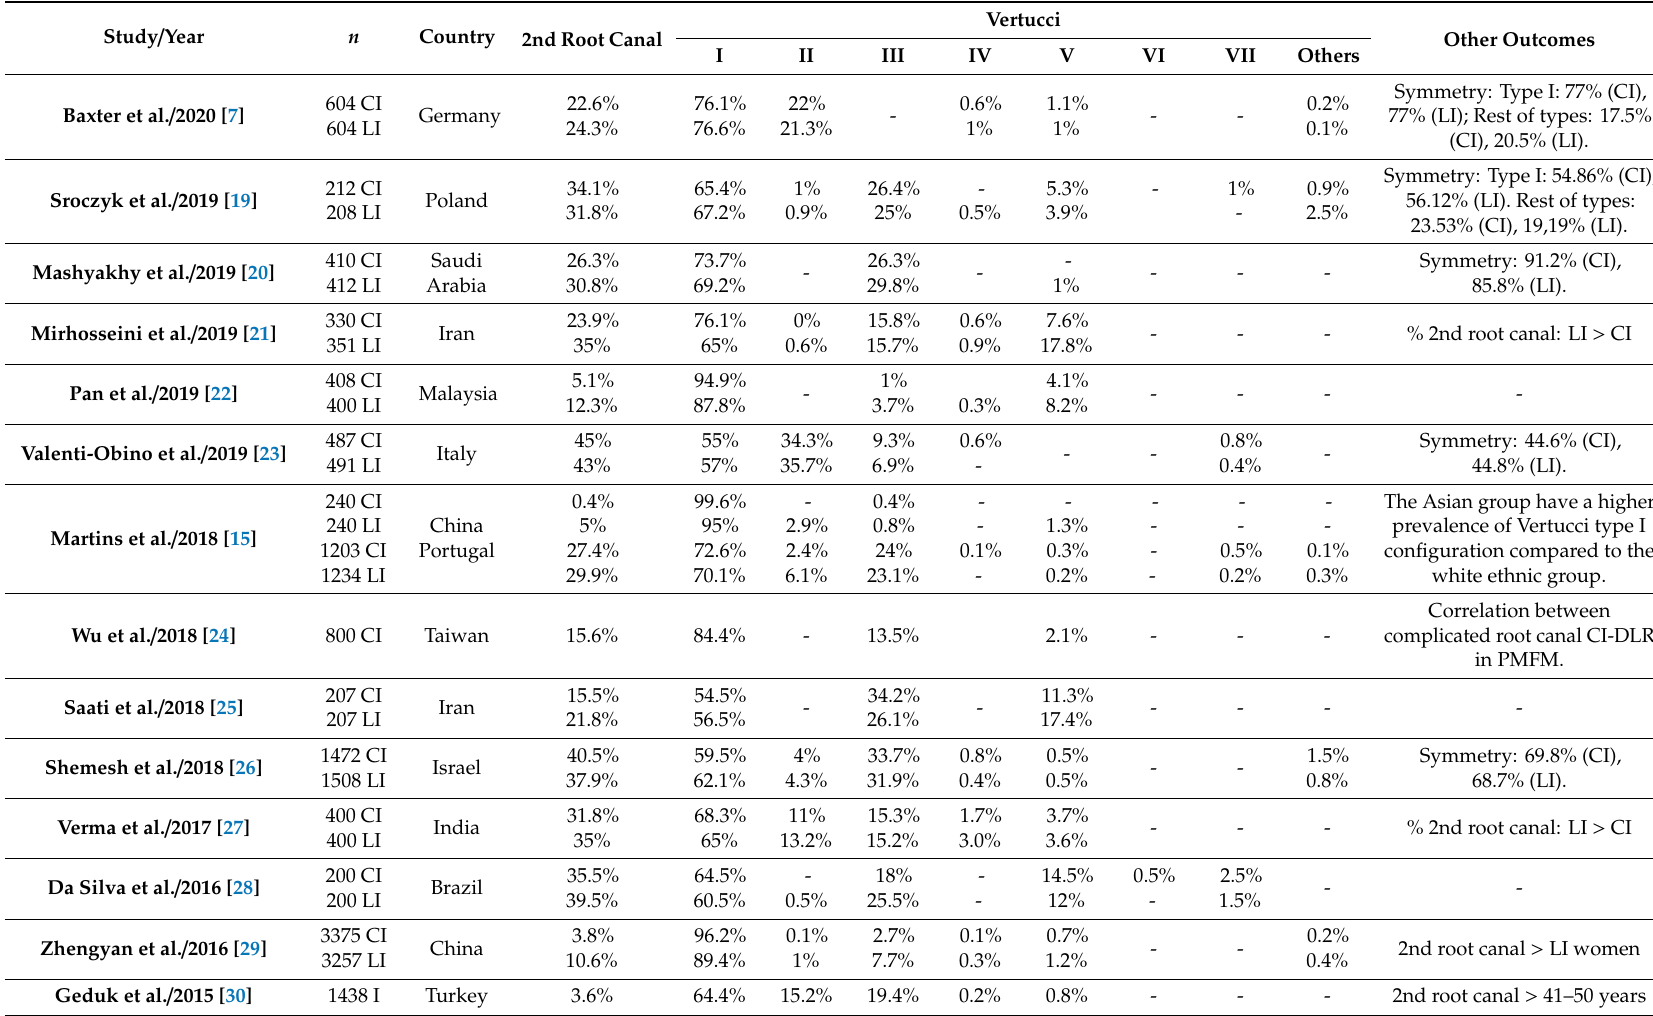
Table 1. Root canal configuration of permanent mandibular